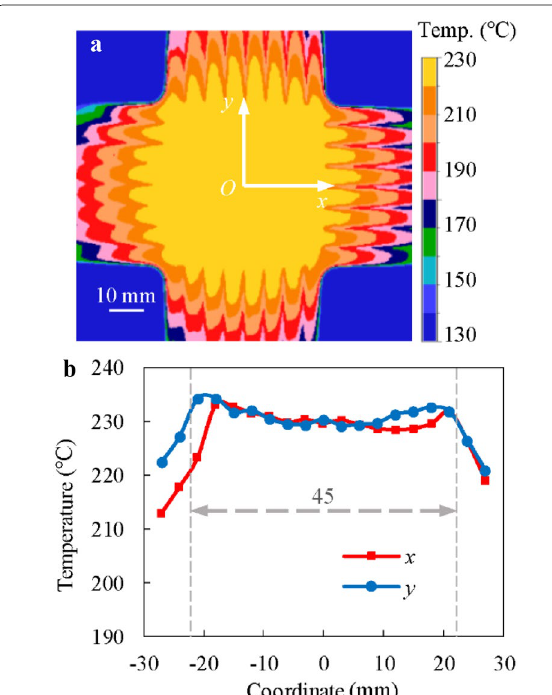
Figure 6 ( a ) Temperature contours of an induction-heated cruciform specimen and ( b ) temperature profiles along x-axis and y-axis